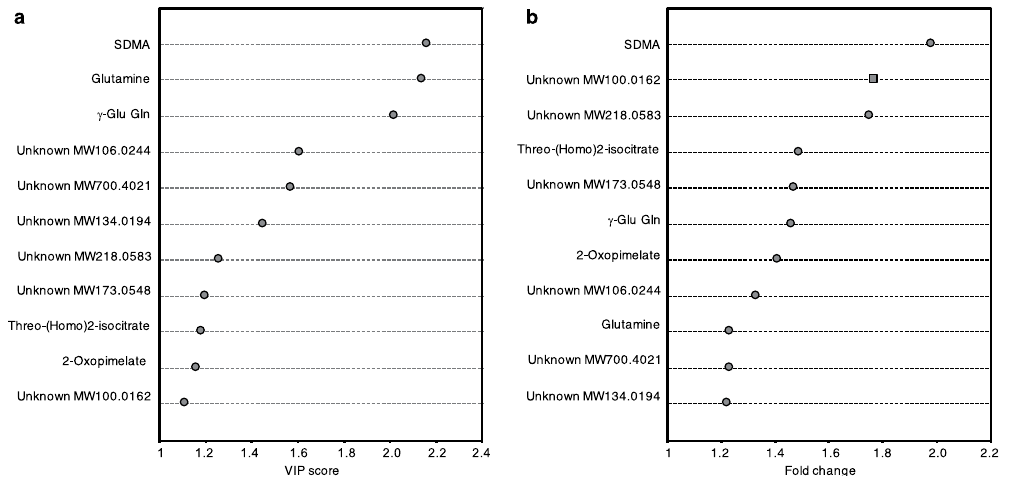
Figure 2. Distributions of VIP scores and fold changes among statistically significant metabolites. ( a ) Distribution of VIP scores among statistically significant metabolites. ( b ) Distribution of fold changes among statistically significant metabolites. Dots indicate positive fold changes whereas squares indicate negative fold changes. SDMA, symmetric dimethylarginine; γ -Glu Gln, γ -glutamylglutamine; VIP, variable importance on projection.